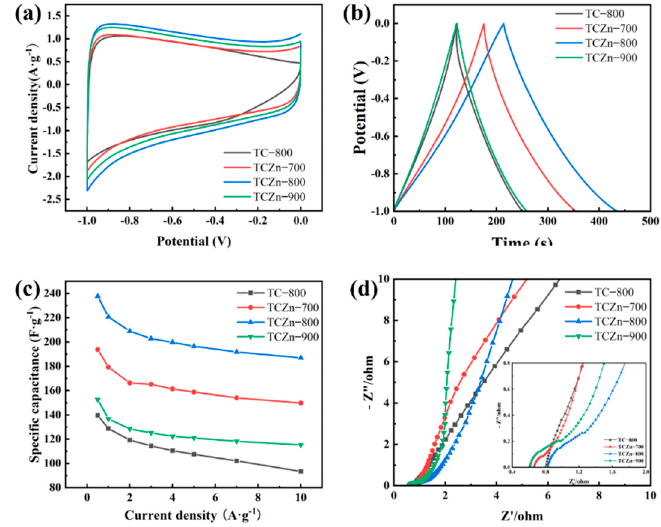
Figure 5. Electrochemical properties of all samples ( a ) CV curves at 10 mV·s − 1 ; ( b ) GCD curves at 1 A·g − 1 ; ( c ) Specific capacitance at different current densities and ( d ) Nyquist plots.